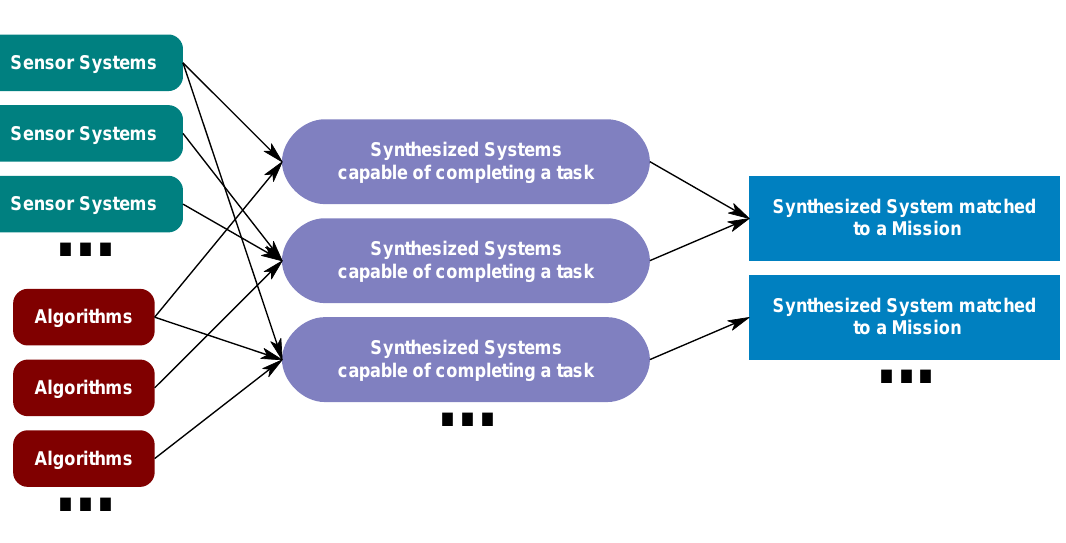
Figure 2. Creation of synthesized systems which are then assigned to subtasks of high-level missions via the ontological problem-solving